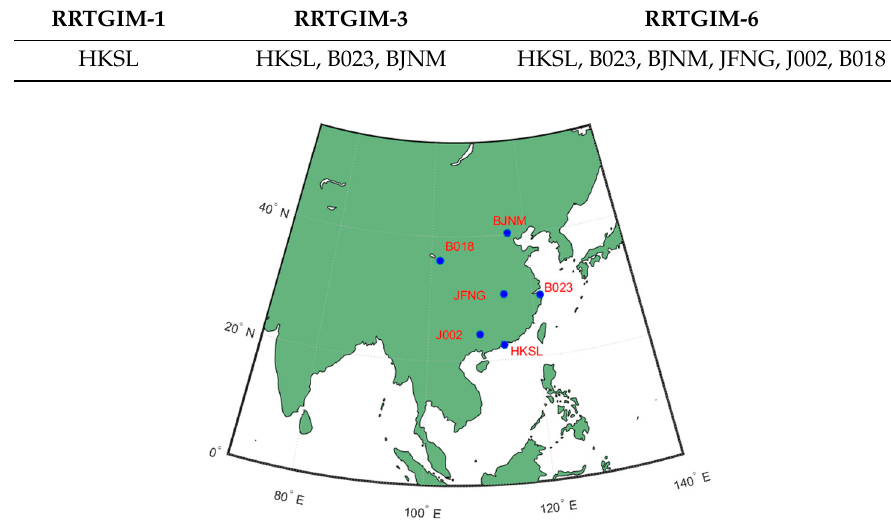
Table 2. Global navigation satellite systems (GNSS) stations used for refinement modeling.